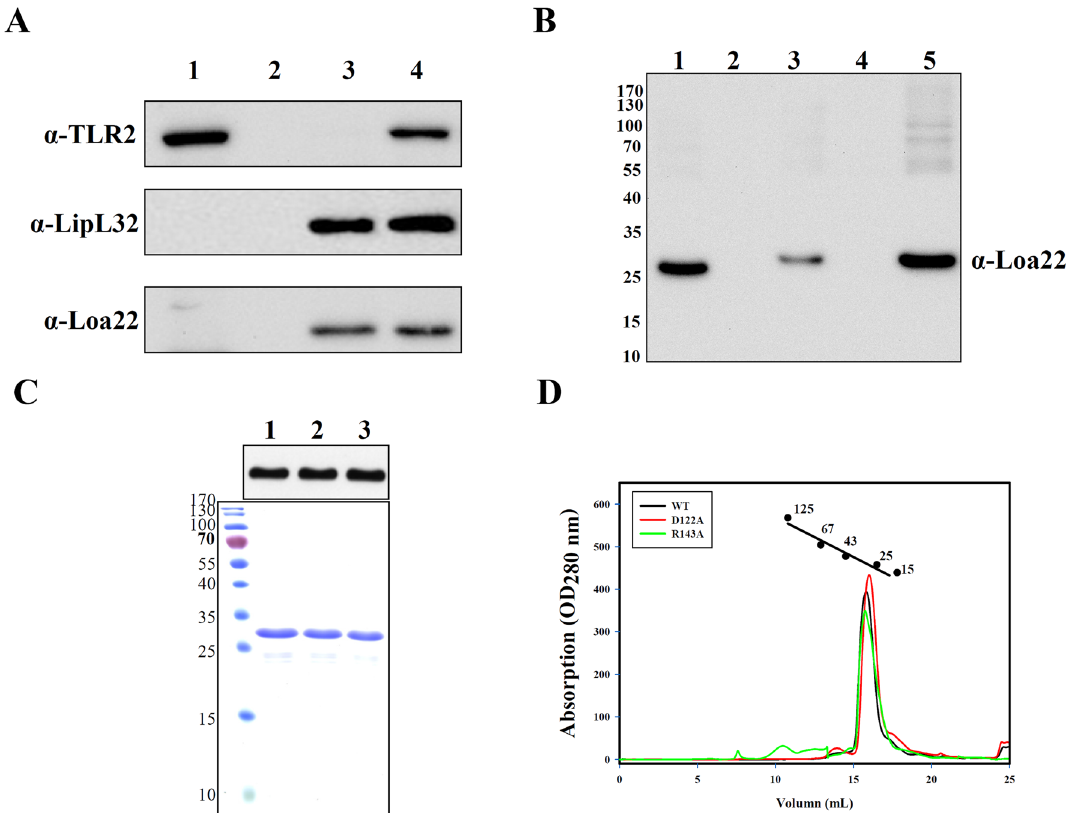
Figure 1. Characterization of TLR2 binding proteins from Leptospira . ( A ) Immuno-precipitant of purified TLR2 protein and Loa22 protein. Anti-TLR2, anti-LipL32 and anti-Loa22 antibodies were used to detect the presence of these proteins. Lane 1: anti-V5 antibody activated Protein A beads incubated with HEK293-TLR2 cell lysate; lane 2: anti-V5 antibody activated Protein A beads incubated with LOMP; lane 3: LOMP; lane 4: Co-IP of TLR2 and LOMP fractions. ( B ) The expression of Loa22 protein in different species and fractions of Leptospira . Recombinant Loa22 (rLoa22) was used as positive control (lane 1). Peptidoglycan from L. santarosai (LPGN) was also used to detect the presence of Loa22 protein (lane 2). LOMPs from different species of Leptospires were used to detect the presence or absence of Loa22 protein including pathogenic L. interrogans (lane 3), non-pathogenic L. biflexa (lane 4), and L. santarosai (lane 5). Rabbit polyclone anti-Loa22 antibody was use to recognize the protein. ( C ) Purification of the Loa22 and mutation variants. Wild type and mutation variants were analyzed by SDS-PAGE (lower panel) and Western blot (upper panel; recognized by anti 6XHis tag antibody) Lane 1: WT Loa222; lane 2; Loa22D122A; lane 3: Loa22R143A. ( D ) Size exclusion chromatography of purified Loa22 protein. The single peak of purified Loa22 protein with molecular mass about 22 kDa indicated that the protein was of uniform conformation. The standard markers were ferritin (440 kDa), β-galactosidase (125 kDa), albumin (67 kDa), ovalbumin (43 kDa), chymotrypsinogen A (25 kDa), and ribonucleaseA (15